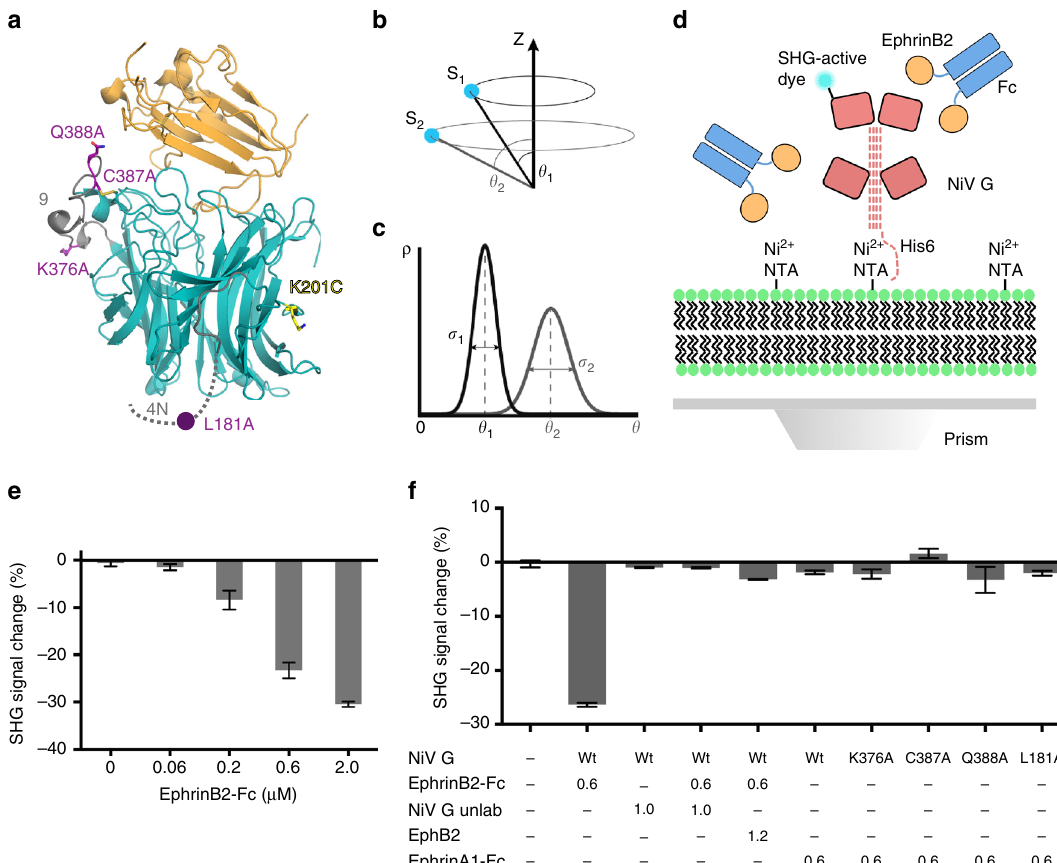
Fig. 1 Detection of ephrinB2 binding to NiV G by SHG. a Crystal structure of the globular domain of NiV G bound to the globular domain of ephrinB2. NiV G conformational mutants are indicated in purple , and the dominant labeling site of NiV G is indicated in yellow . Epitopes for conformation-sensitive antibodies mAb45 and mAb213 are indicated in gray . b Prior to ligand binding, the SHG label representing protein conformational ensemble S1 has an average orientation angle θ 1 relative to the surface normal. Ligand binding elicits protein conformation ensemble S2 with an average label orientation θ 2 . c The SHG signal depends on both the average label orientation θ and the width of the orientational distribution σ of the probe. Rearrangements in protein structure upon ligand binding that result in changes of either θ , σ , or both will be re fl ected in the SHG signal change. d Biodesy read plate setup. A NiV G ectodomain construct with an N-terminal His6-tag was oriented in a fi xed manner via binding of the His6-tag to Ni-NTA groups on a supported lipid bilayer. The globular domains are represented by pink rectangles , and the stalk domain by dashed pink lines . e Δ SHG concentration-dependent dose- response of ephrinB2-Fc binding to NiV G. His6-tagged NiV G ectodomain construct was bound to Ni-NTA-containing supported lipid bilayer at 0.5 μ M. EphrinB2-Fc was added to the indicated fi nal concentrations. f Negative controls for SHG response in NiV G ectodomain constructs. NiV G was bound at 0.5 μ M and ephrinB2 constructs and competitors were added at indicated amounts ( μ M). Mean and s.d. values for SHG data are shown from